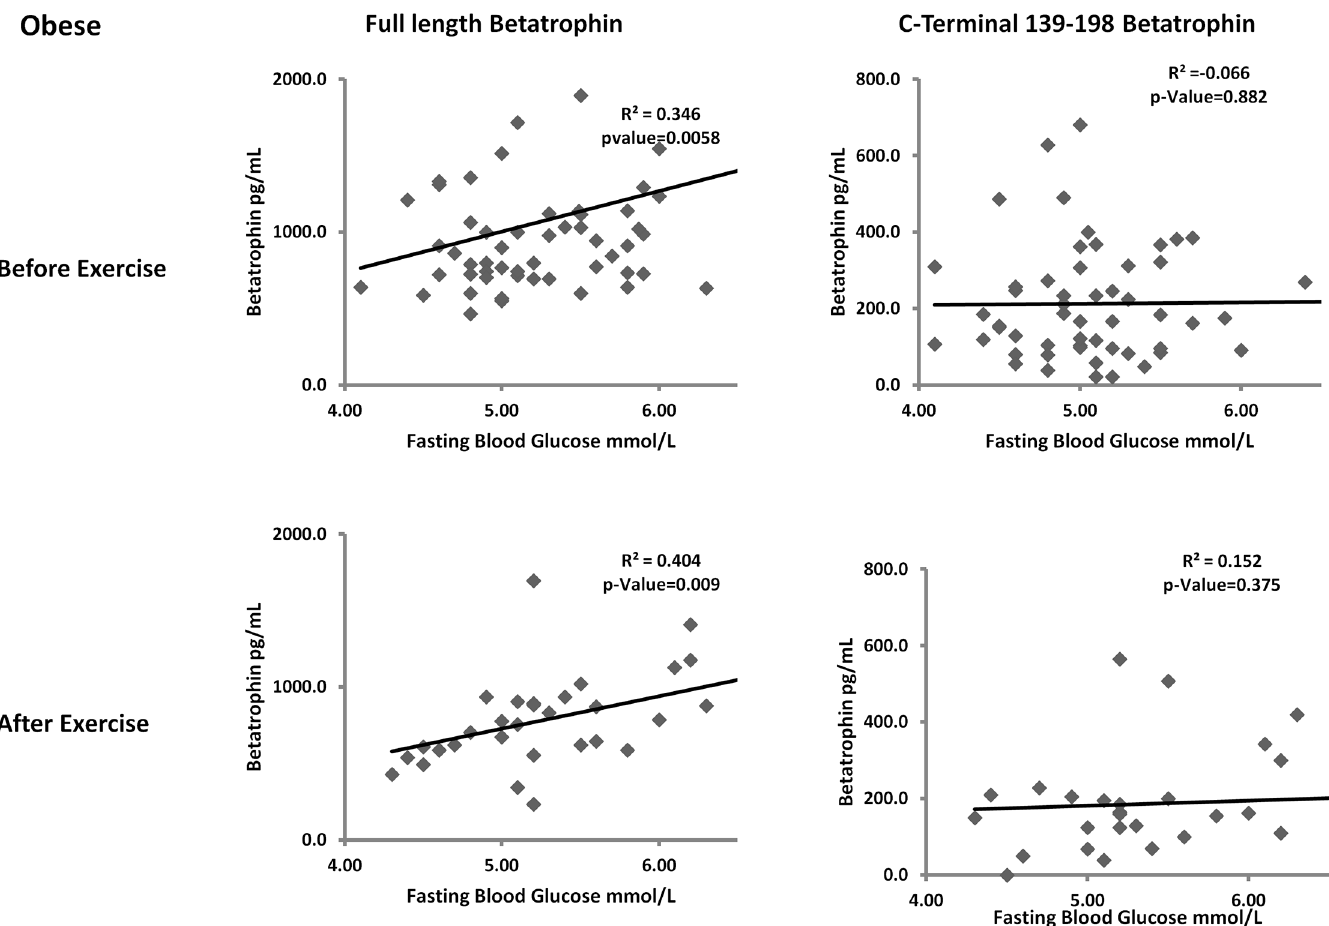
Fig 4. Spearman ’ s correlation between full length and C-terminal form of ANGPTL8 and FBG in the obese group before and after exercise adjusted for age gender and